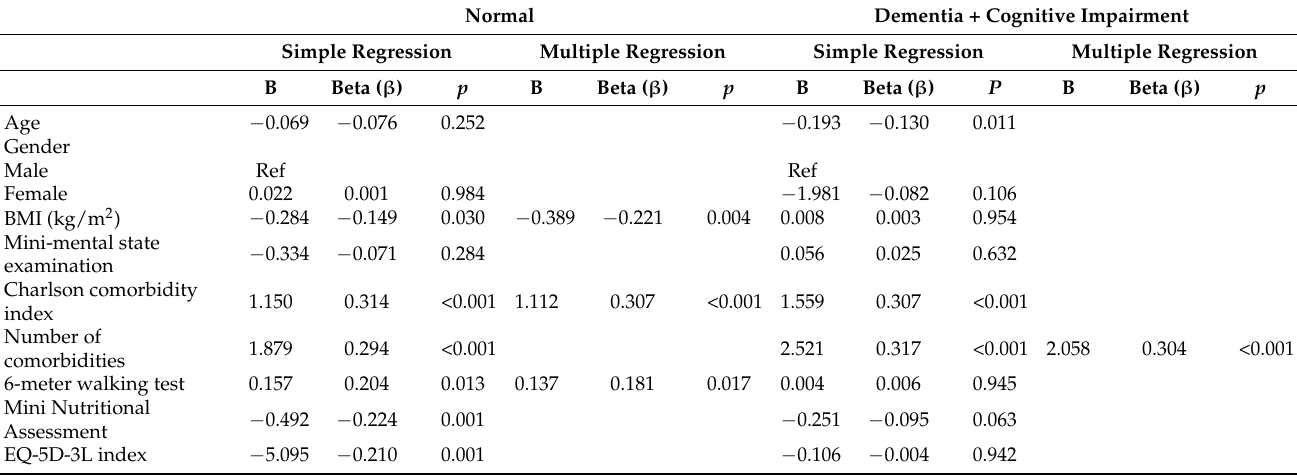
Table 4. Predictors of Length of Stay.